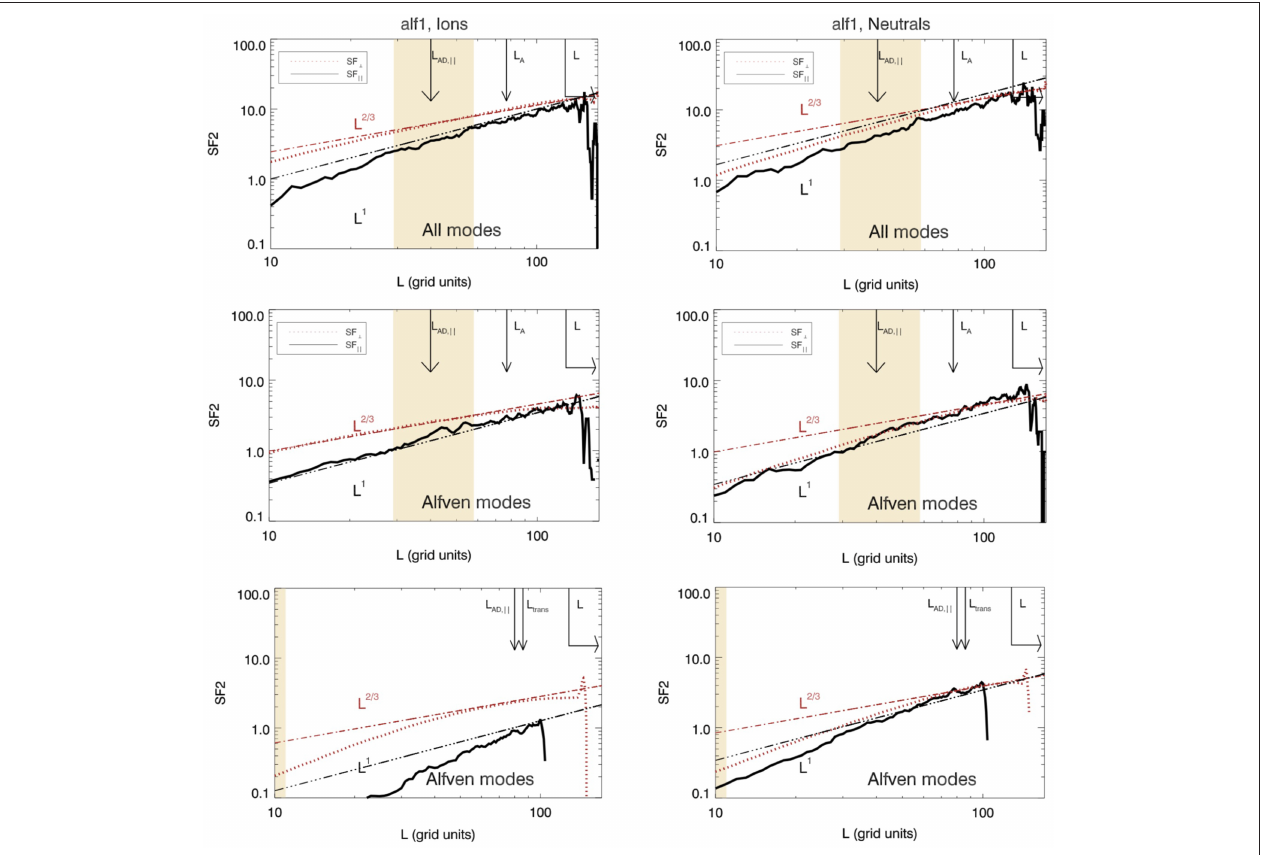
FIGURE 6 | Structure function in MHD turbulence with ion-neutral friction from Burkhart et al. (2015). (Left panel) Show the structure function for the ions while the right panels display the structure functions for the neutrals. The first and second rows are for a supersonic and super Alfvénic simulation while the third row is for a sub-Alfvénic one. For the second and third panel mode decomposition has been performed and only the Alfvén modes are shown. As can be seen from third row, they are strongly damped in the sub-Alfvévic case why they roughly follow the expected scaling from ideal MHD theory in the super-Alfvénic one. Reproduced from Burkhart et al. (2015) with permission of